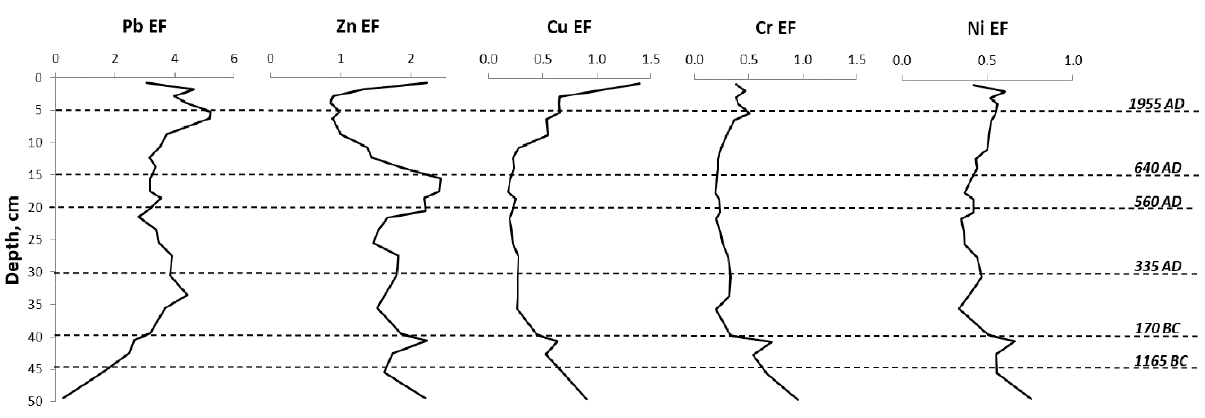
Figure 6. Pb, Zn, Cu, Cr and Ni enrichment factors (EFs) in Core W3. The EFs were calculated using K as the reference